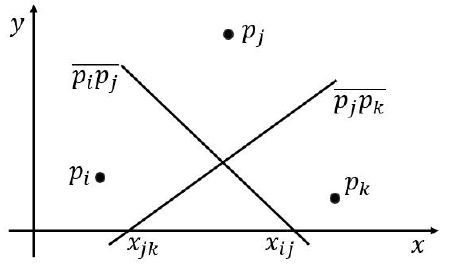
Figure 7. An Example of Deleting Point p j .